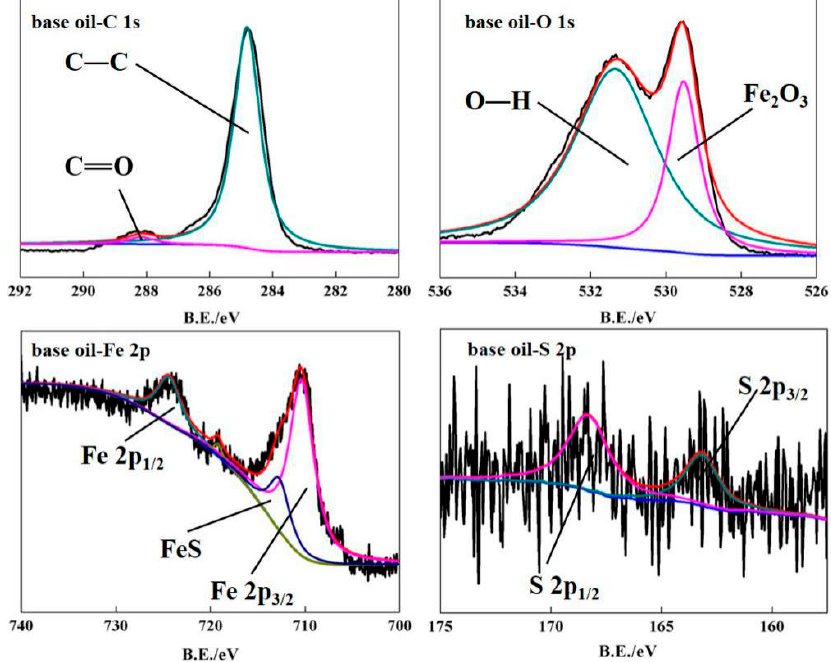
Figure 9. XPS spectrum of steel ball surface after friction test of SN500 base oil.